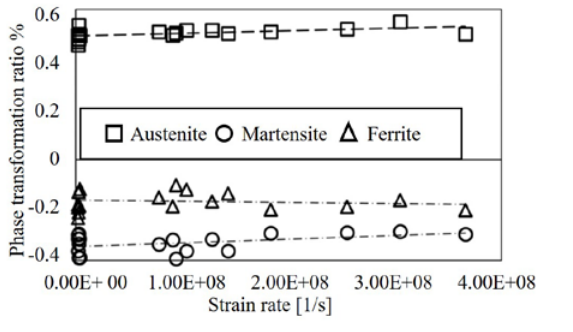
Fig. 5. Effects of strain rate on phase